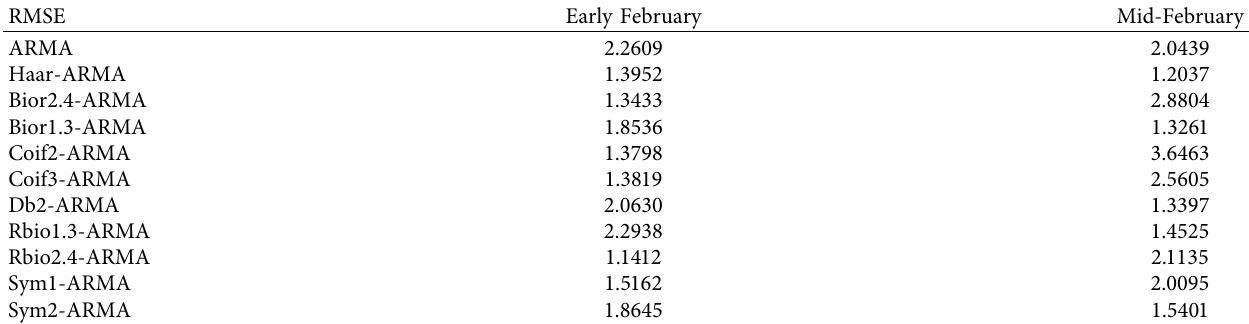
Table 1: The RMSE comparison of 10 DWTs-ARMA and single ARMA